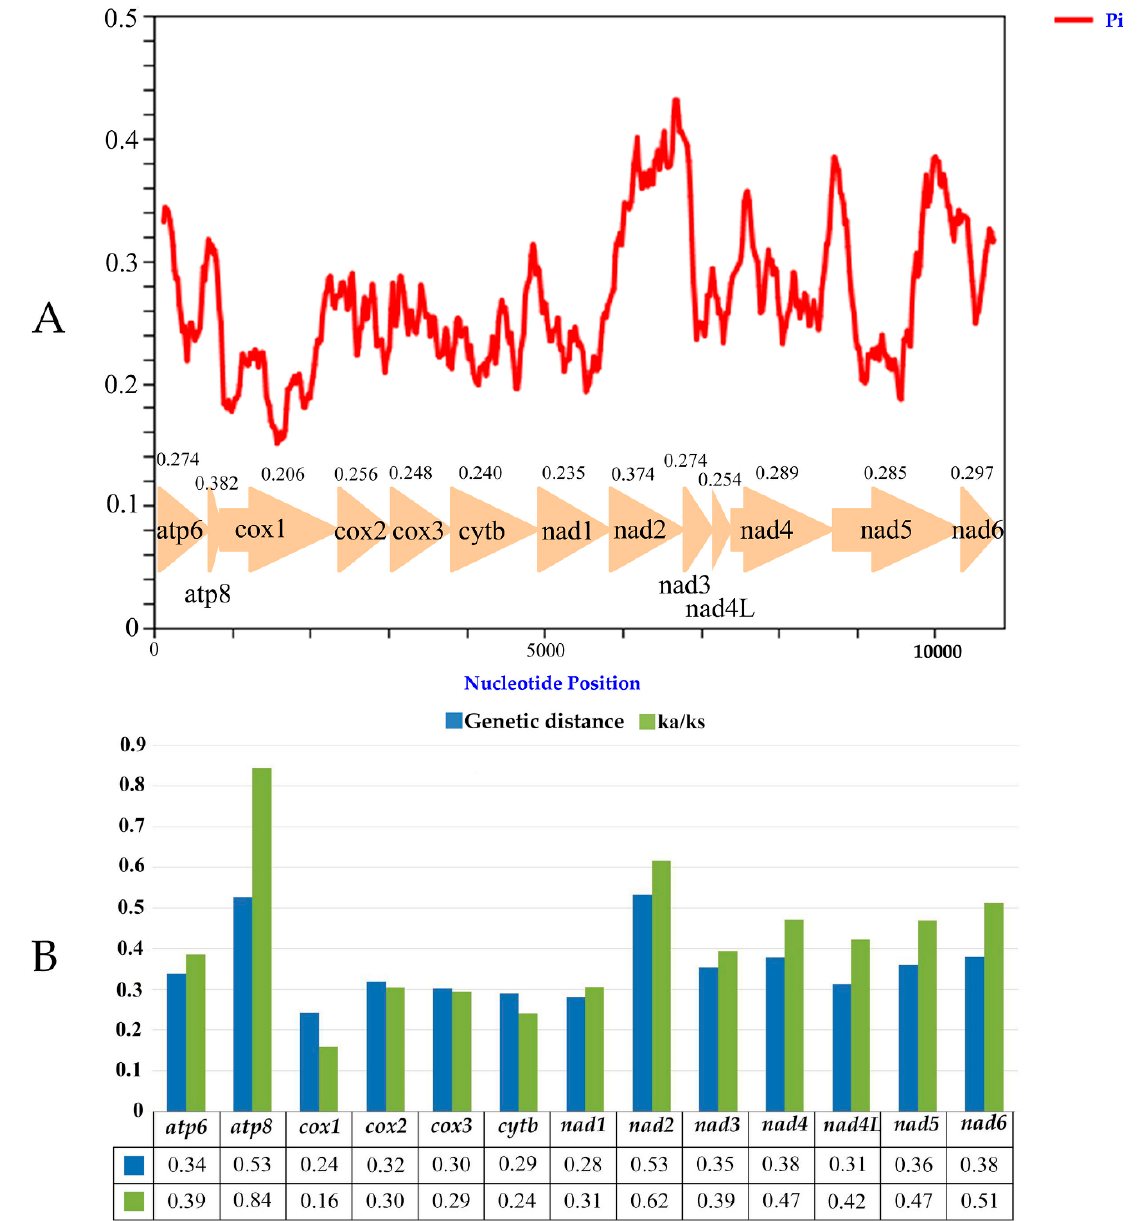
Figure 5. ( A ) Sliding window analyses of 13 PCGs among 22 species of Typhlocybinae, the red line shows the value of nucleotide diversity Pi. ( B ) Genetic distances and the ratio of non-synonymous (Ka) to synonymous (Ks) substitution rates of 13 PCGs among 22 species of Typhlocybinae, the average value for each PCG is shown under the gene name. The cox1 gene is one of the most universal markers for identifying species and ana- lyzing the phylogenetic relationships of leafhoppers [53–55], but it has the lowest Pi val- ues, genetic distance and Ka/Ks rates, indicating it is the most conserved gene within the 13 PCGs among the 22 Typhlocybinae mitogenomes. Meanwhile, atp8 and nad2 are the fastest evolving genes, suggesting that atp8 and nad2 would be two ideal candidate mark- ers for sibling species delimitation and population genetic differentiation in Typhlocybi- nae.